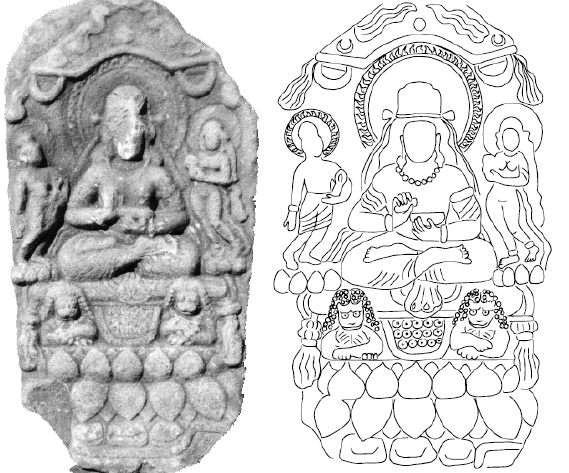
Figure 1. Stele n.17: photo (on the left) and drawing (on the right). Seated siddha (?) with attendants. Irregularly oval- shaped stele, with straight cut on the sides.